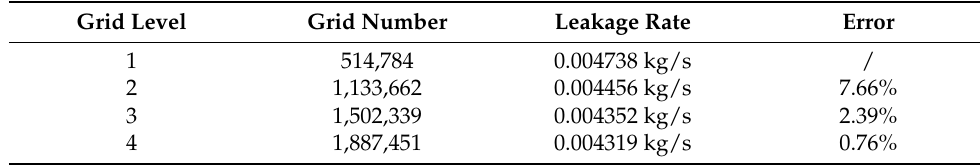
Table 3. Grid independence